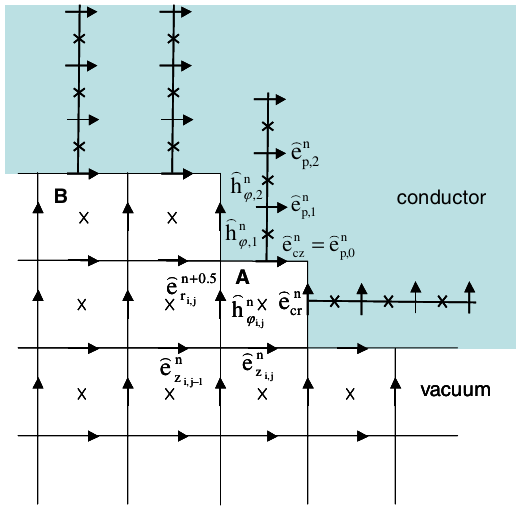
FIG. 7. Two-dimensional view of the cylindrical mesh of the vacuum region.